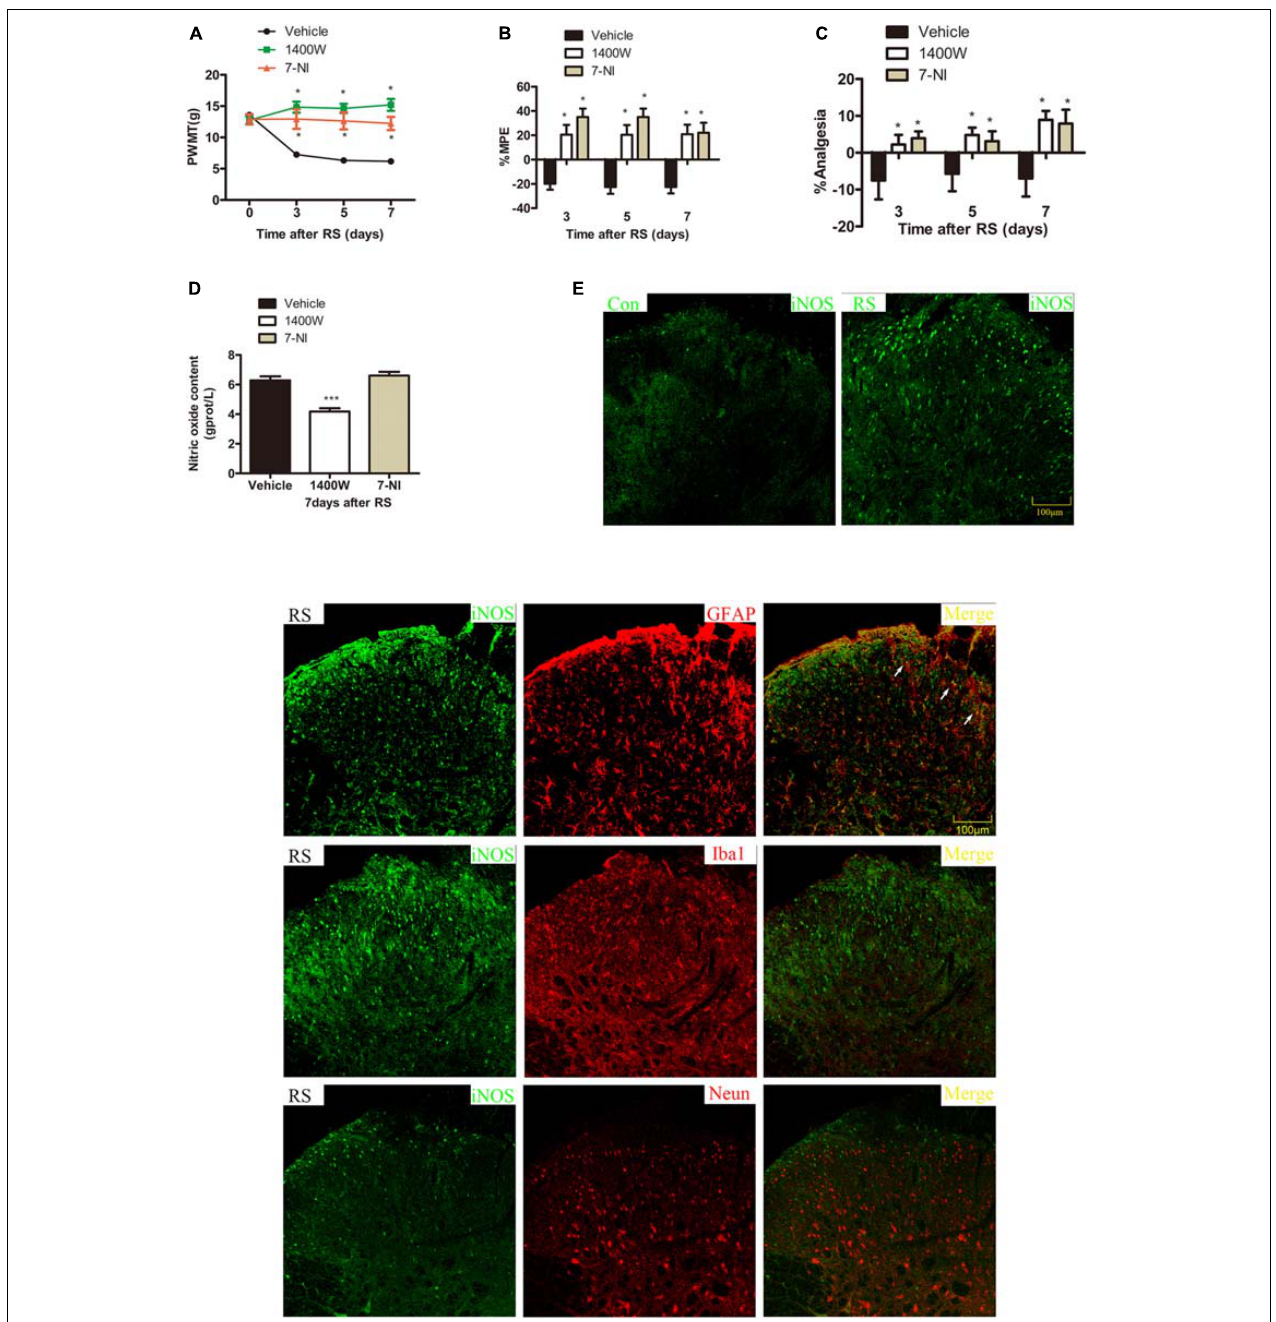
FIGURE 7 | Effect of specific 1400 W or 7-NI on nociceptive behavior and spinal NO in rats subjected to chronic RS, and the cell type specificity of iNOS. Chronic RS rats were consecutively treated with either 1400 W (1 µ g/ml, 10 µ l) or 7-NI (40 µ g/ml, 10 µ l). (A–C) Nociceptive behavior tests including PWMT (treatment: F 2 , 25 = 20.961, P < 0.001; observation intervals: F 3 , 75 = 4.045, P = 0.016; interaction: F 6 , 75 = 9.247, P < 0.0001), PWTL (treatment: F 2 , 25 = 15.561, P < 0.001; observation intervals: F 2 , 50 = 2.038, P = 0.154; interaction: F 4 , 50 = 1.831, P = 0.158), and TFL (treatment: F 2 , 25 = 4.898, P = 0.016; observation intervals: F 2 , 50 = 3.174, P = 0.064; interaction: F 4 , 50 = 1.1, P = 0.362). (D) Effect of 1400 W or 7-NI on the expression of spinal NO, F 2 , 15 = 27.36, P < 0.001. Data are shown as mean ± SEM ( n = 8–10). *Significant difference with respect to vehicle groups (two-way ANOVA with repeated measures in nociceptive behavior tests and one-way ANOVA in spinal NO measurement followed by Bonferroni post hoc test or Dunnett’s T3 test if necessary), * P < 0.05 and *** P < 0.001. (E) In the superficial layer of the spinal dorsal horn (lamina I–III), iNOS-positive cells were increased in the RS rats compared with control rats. (F) Confocal images of iNOS immunostaining (green) and its colocalization with astrocytes (GFAP, red), but not with microglia (Iba1, red) or neurons (Neun, red) in the superficial spinal dorsal horns (lamina I–III, n = 3 in each group). Scale bar = 100 µ m. 7-NI, 7-nitro indazole; NO, nitric oxide; RS, restraint stress; iNOS, inducible nitric oxide synthase; PWMT, paw withdrawal mechanical threshold; PWTL, paw withdrawal thermal latency; iNOS, inducible nitric oxide synthase.